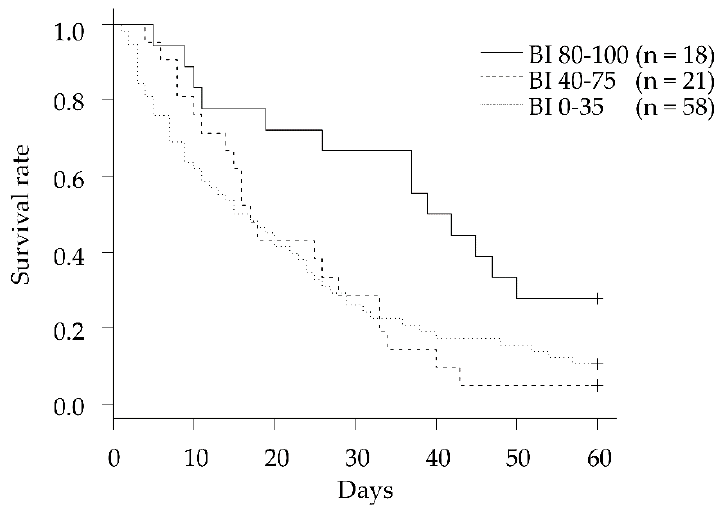
Figure 2. Survival analysis. The Kaplan–Meier method and the log-rank test were performed by classifying the BI (BI 0–35, BI 40–75, BI 80–100). The BI 0–35 group was 58 patients; the BI 40–75 group was 21 patients; and the BI 80–100 group was 18 patients. BI: Barthel Index. Table 2. Sensitivity, specificity, positive and negative predictive values, accuracy, and area under the receiver operating characteristic curves of the Barthel Index and Glasgow Prognostic Score.